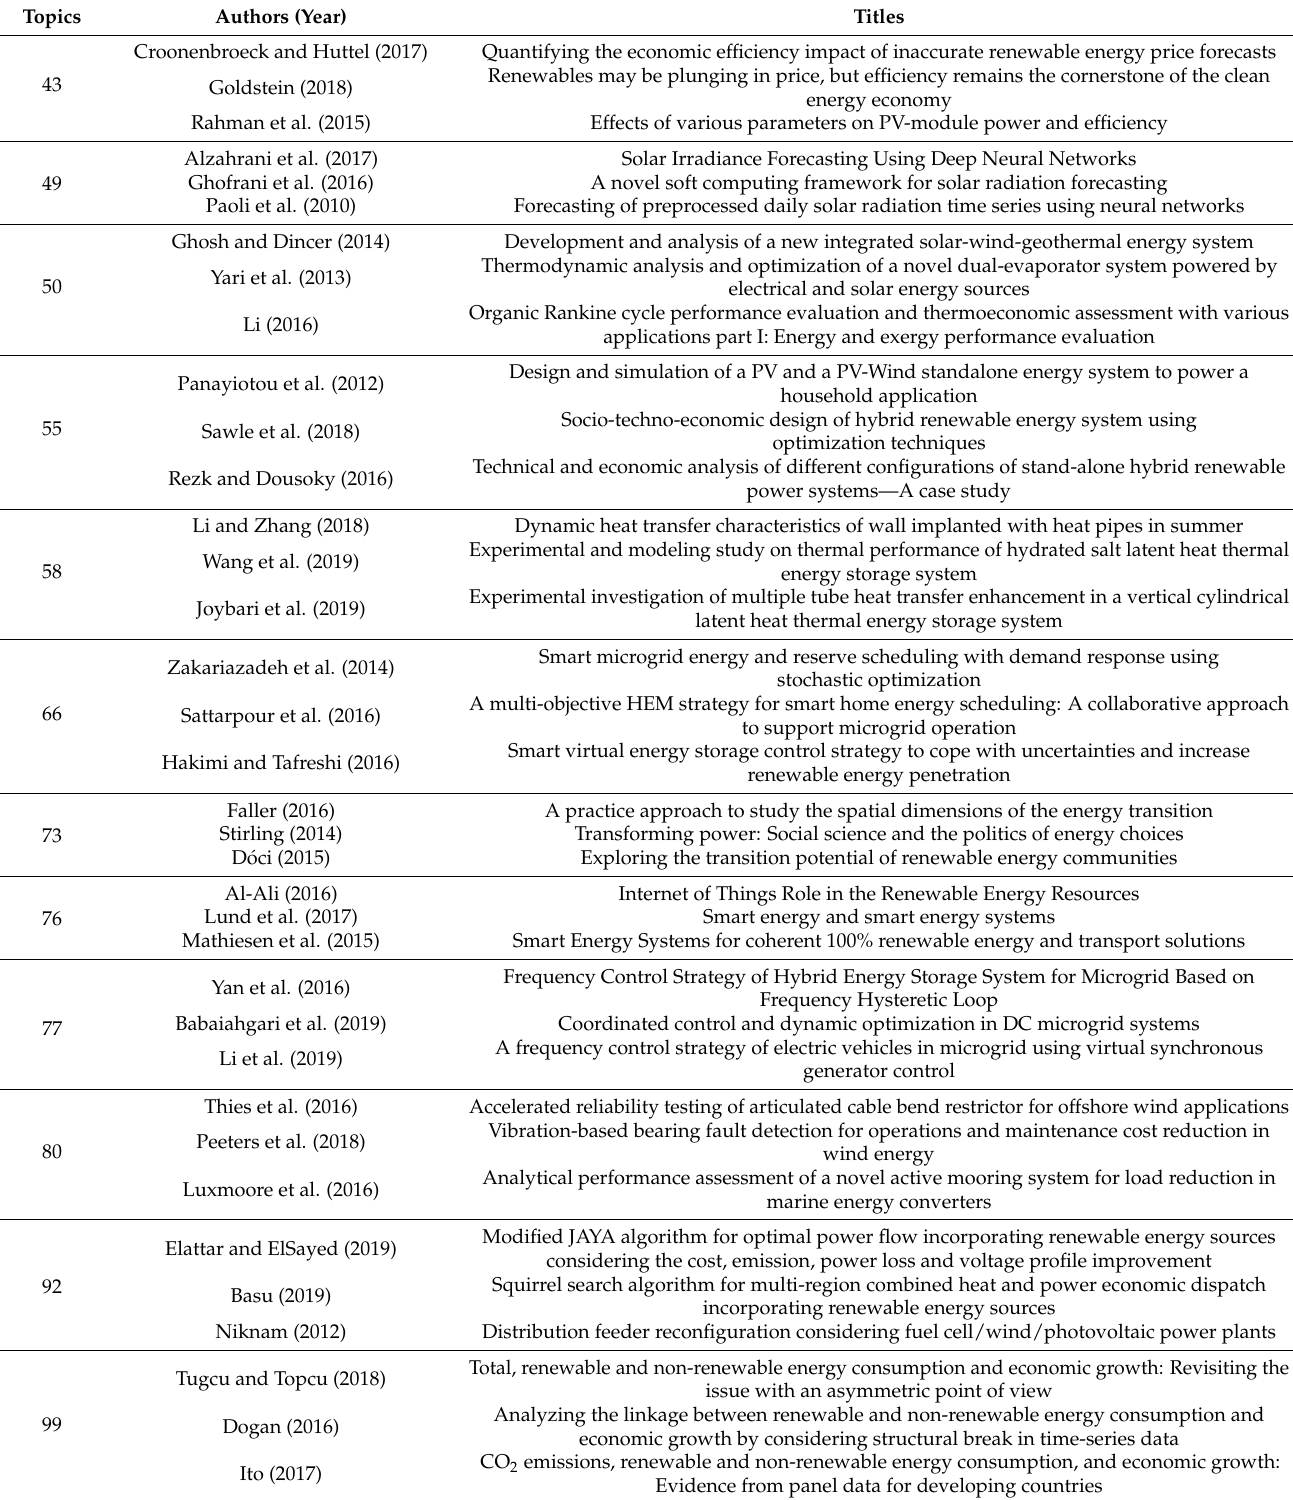
Table 4. Relevant documents with strong signal topics 1